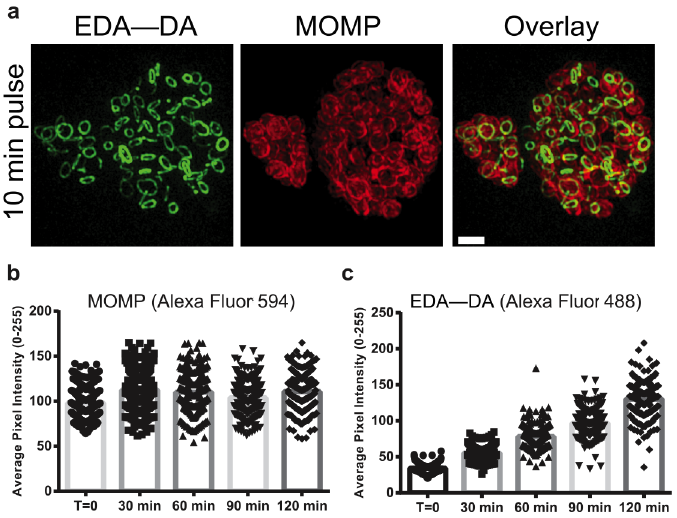
Fig 5. C . trachomatis incorporates DAADs rapidly during exponential growth. (a) SIM of chlamydial inclusions (18 hpi) incubated for 10 min with 4 mM EDA — DA. Z-stacks from chlamydial inclusions (18 hpi) incubated with EDA — DA were collected, maximum intensity projections constructed, and average pixel intensities calculated for entire inclusions for both MOMP (b) and EDA — DA (c) channels. ~200 inclusions were assigned average pixel intensities per time point measured and the entire experiment was carried out in biological duplicates. MOMP and PG labeling is as presented in Fig 2. Scale bar = 1 μ